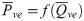
Scheme of the closed-loop heart-circulation model.The circuit is closed by linear venous return law P¯ve=f(Q¯ve) (blue dashed line in the right panel given by Eq (9)), which defines the venous pressure and preload of systemic ventricle according to the cardiac output (MSFP stands for mean systemic filling pressure and Qvemax for maximum achievable venous flow).